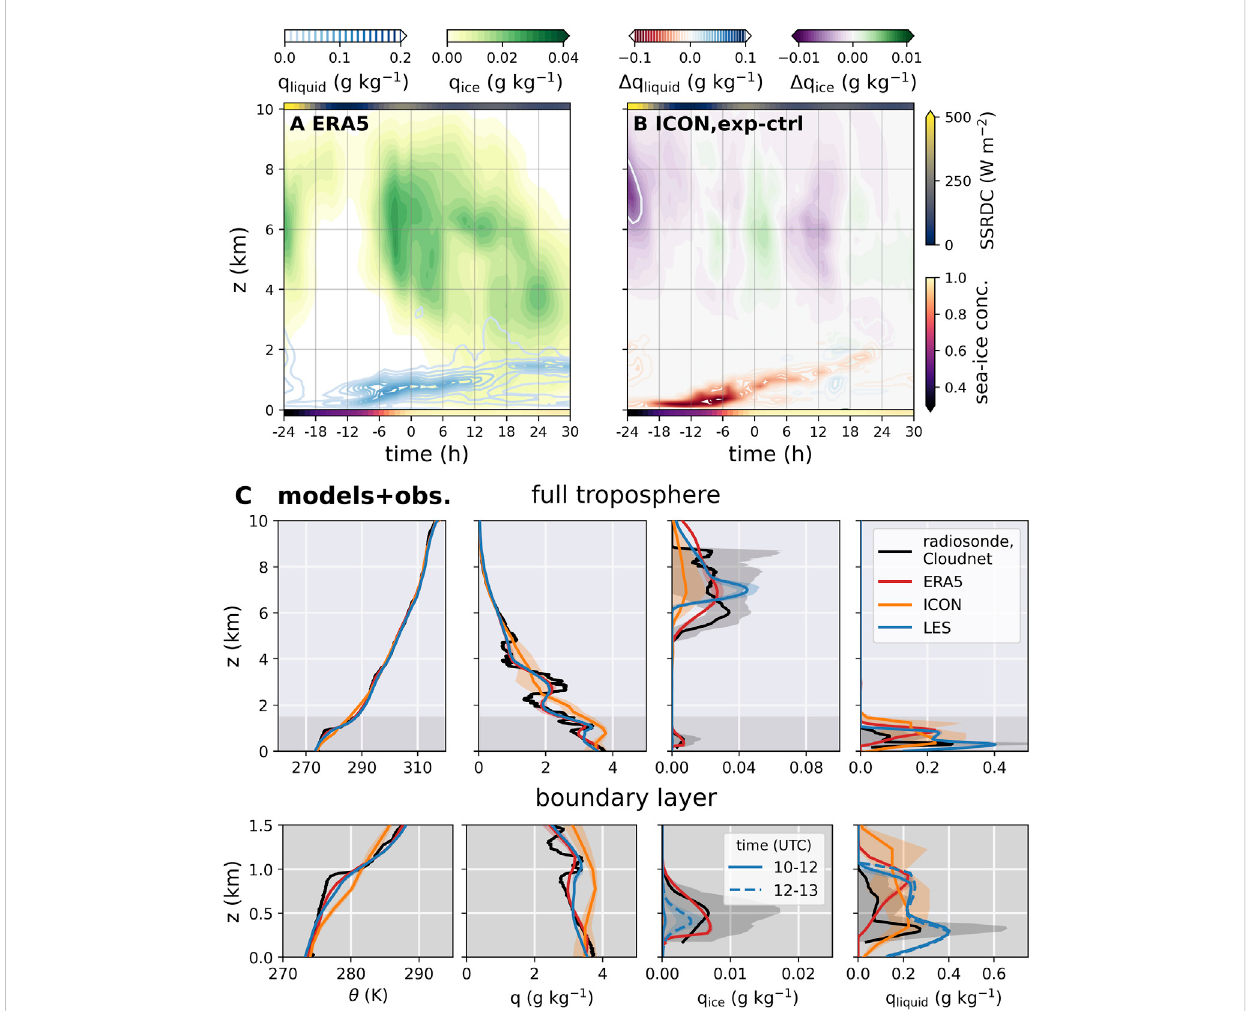
FIGURE 5 (A,B) Height-time cross sections of LWC (q liquid , in blue) and IWC (q ice , in green) along trajectories covering 24 h backward and 30 h forward with time. t = 0 h references 19 April 2020, 12 UTC, at RV Polarstern. Colored line at top of graphs: ERA5-based surface shortwave downward radiation under clear-sky conditions (SSRDC), colored line at bottom of graphs: ERA5-based sea-ice concentration. (A) LWC and IWC along the air mass trajectories based on ERA5, (B) LWC and IWC differences “ EXP — CTRL ” based on ICON-LAM . (C) Vertical thermodynamic and cloud pro fi les simulated and observedatRVPolarsternon19April,averagedfor10 – 12UTC.ShownaretheoutputsfromERA5,controlrunsoftheprocessmodels(LES,ICON-LAM)as wellas observations fromCloudnetand radiosonde (launched at11UTC). Upperpanel:pro fi lecoveringaltitudes of0 km – 10 km,bottompanel: zoomed into lowest levels covering 0 km – 1.5